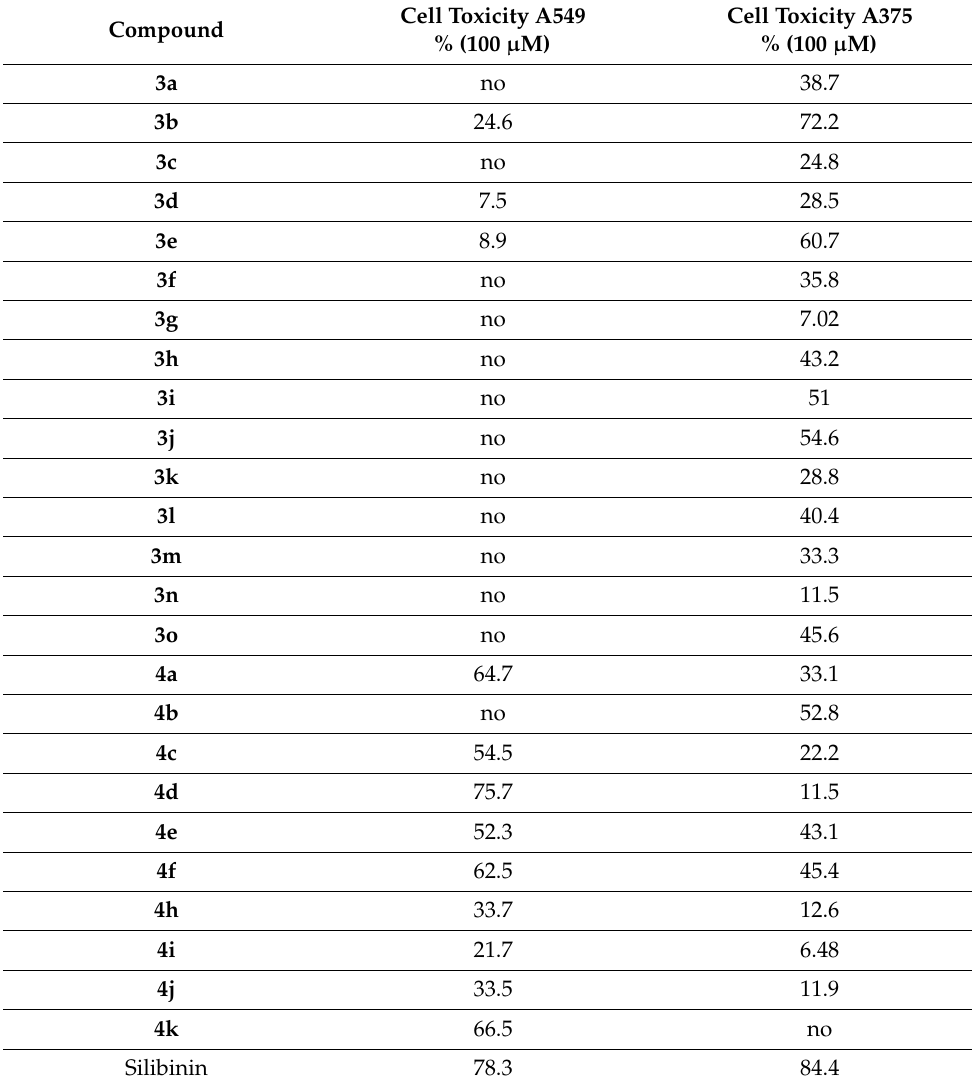
Table 5. Evaluation of coumarin compounds’ cytotoxicity against A549 and A375 cells, expressed as % of cell toxicity at 100 µ M $